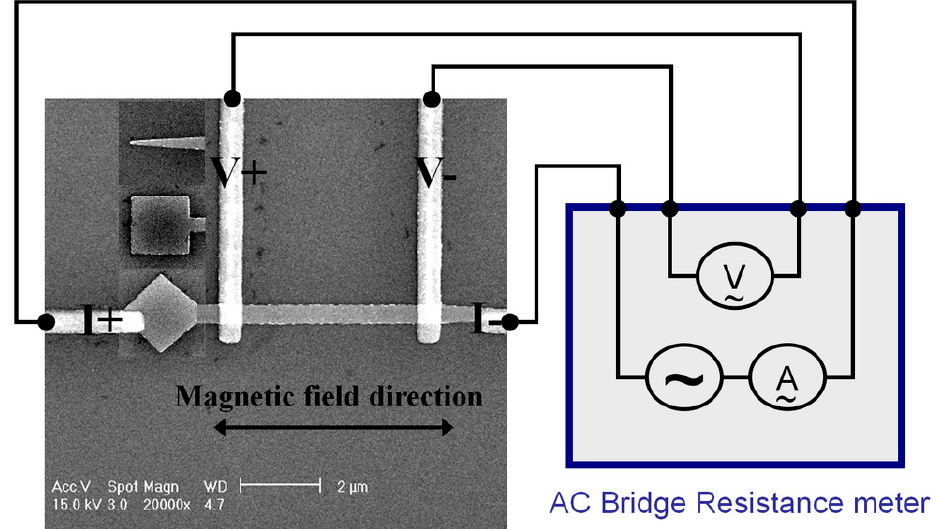
Figure 1. An SEM image of three shapes with I/V contacts. The images on the left side show the varied reservoir and the nanostrips. From top to bottom are the tip, square, and diamond structures.